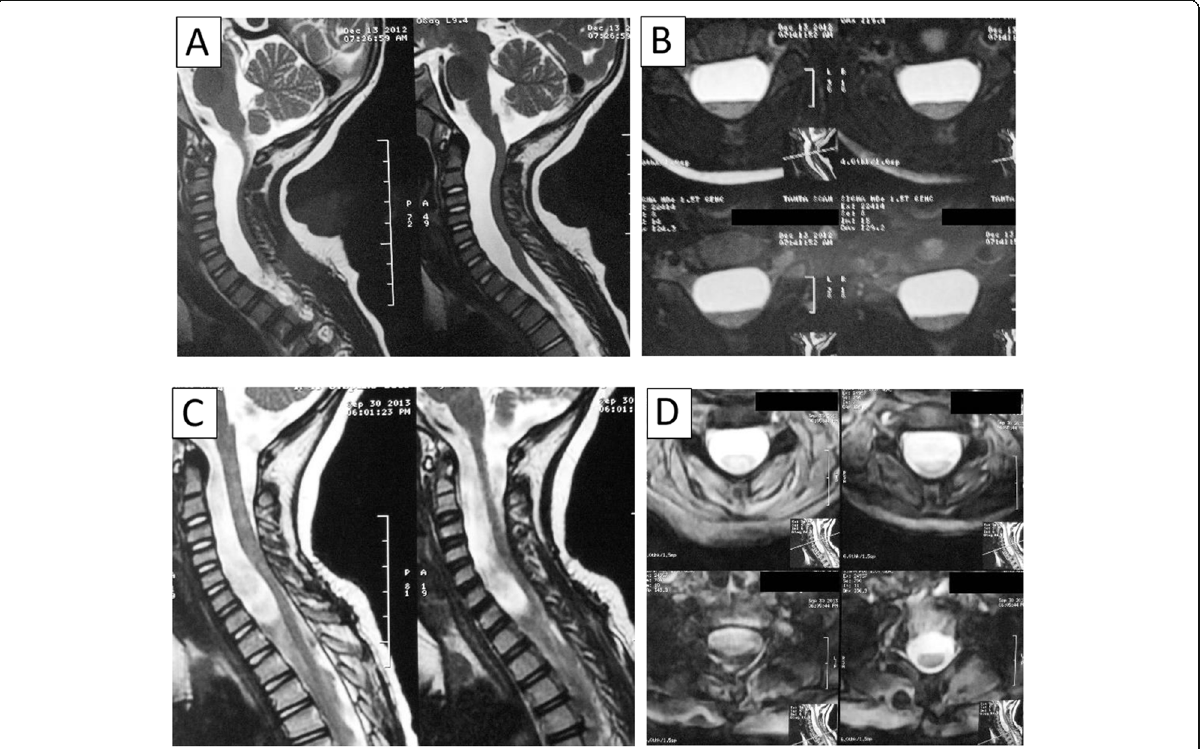
Fig. 1 Case 1: 3-year-old male child presented by delayed motor milestones; clinical examination revealed quadriparesis. Preoperative MRI (a) sagittal T2 and (b) axial T2 showing ventral cervicothoracic spinal arachnoid cyst compressing the cord and pushing it posteriorly. The patient was operated for laminoplasty and cyst wall marsupialization. Follow-up MRI 3 months later (c) sagittal T2 and (d) axial T2 showing cord decompression and return to original position. The patient was clinically and radiologically stable during annual